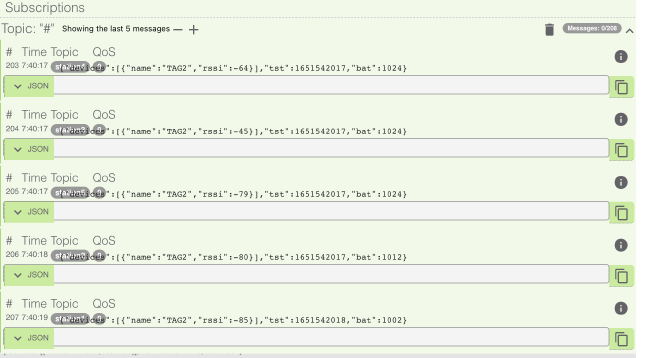
Figure 16. The MQTTLens application, showing the MQTT broker traffic information (taken from